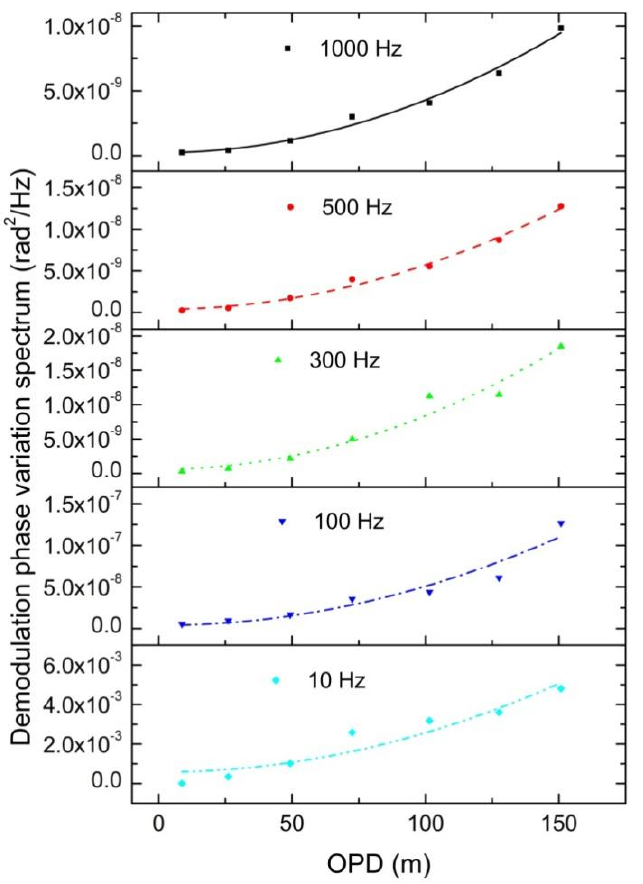
Figure 4. The PSD of the measured differential phase with respect to OPD at different frequencies f m of 10 Hz, 100 Hz, 300 Hz, 500 Hz, and 1000 Hz. The lines are the corresponding fitted results.